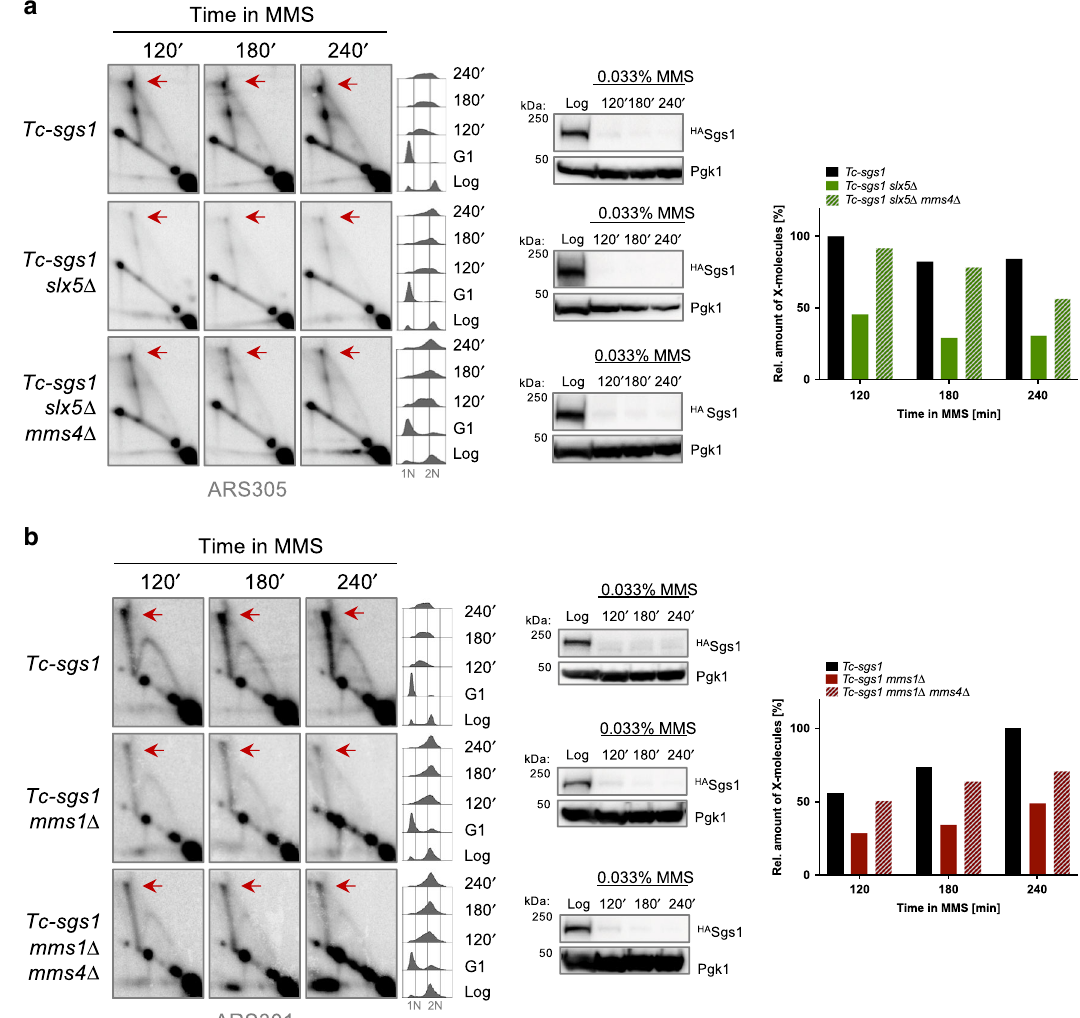
Fig. 5 STUbL and Cullin8 protect replication-associated recombination structures by preventing unscheduled Mms4/Mus81-dependent processing. a 2D gel pro fi les of recombination intermediates isolated from cells of the indicated genotype. Cells were synchronized in G1 phase with α -factor and then released in medium containing 0.033% MMS. Tetracycline 1 mM was added during G1 arrest and release. Samples for 2D gel analysis were collected at the indicated timepoints and levels of HA-tagged Sgs1 were monitored by western blot. Immunodetection of Pgk1 served as a loading control. Cell cycle progression of the cells during the experiment was followed by fl ow cytometric analysis. 1N and 2N in gray indicate G1 and G2/M phases, respectively. Replication intermediates were digested with Nco I and visualized using a radioactively labeled probe speci fi c for ARS305 in 2D gel electrophoresis. Red arrows indicate X-shaped replication intermediates, the relative enrichment of which is shown in the quanti fi ed plots. Signal intensities were normalized to the monomer spot and shown relative to the highest value assigned as 100%. b 2D gel pro fi les of recombination intermediates isolated from cells of the indicated genotype. Experimental set-up as in a . The replication intermediates were digested with Eco RV and Hind III and visualized using a radioactively labeled probe speci fi c for ARS301. Source data are provided as a Source data fi